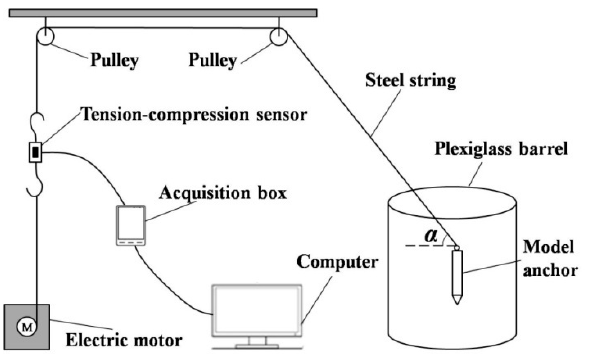
Figure 3. Schematic of the pullout test setup.